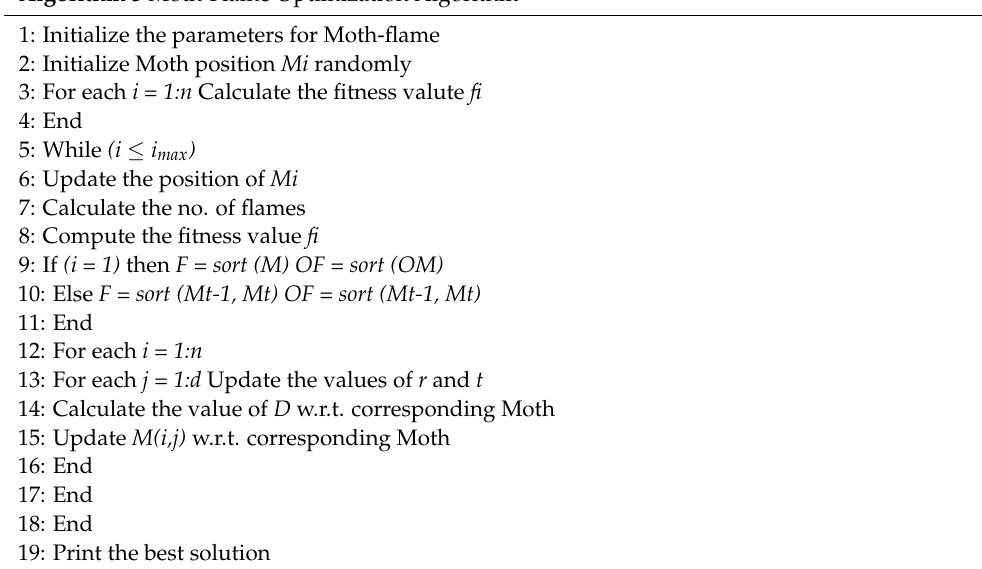
Algorithm 3 Moth-Flame Optimization